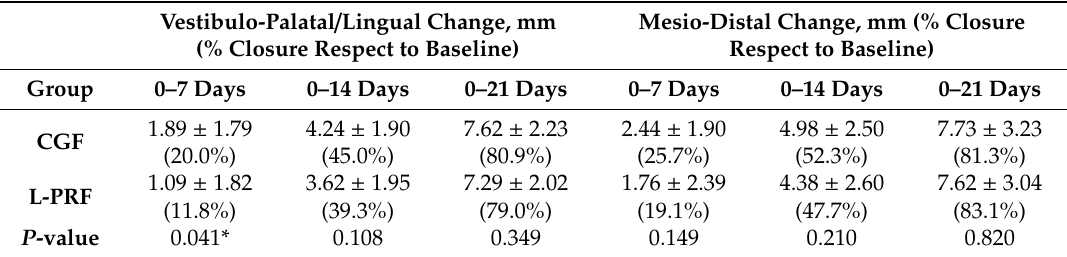
Table 2. Changes in alveolar size (closure) up to 21 days in the vestibulo-palatal / lingual and mesio-distal dimension in the two groups. Di ff erences with baseline values are expressed in mm as mean values ± standard deviation, and in percentage of closure with respect to